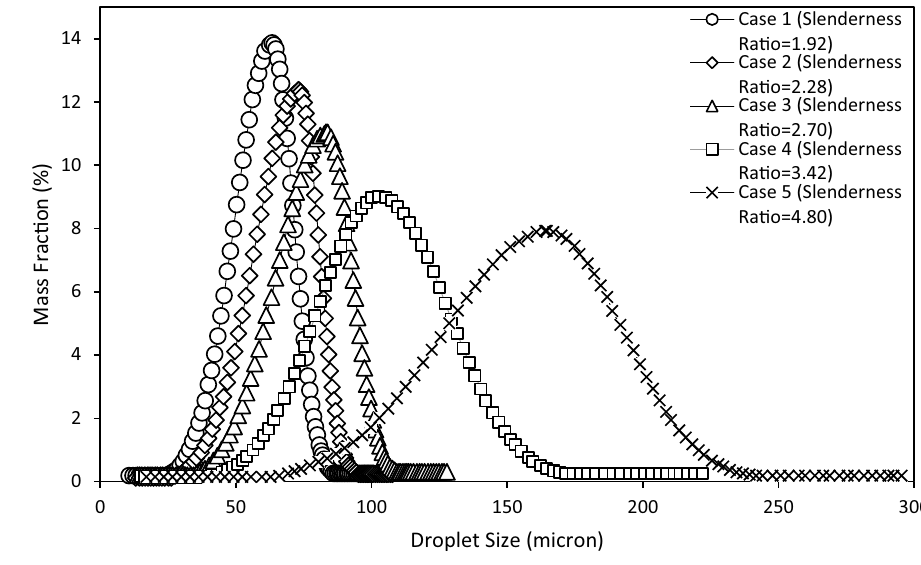
Fig. 12 Simulated diameter distribution of the secondary- phase droplets in the gas outlet of Cases 1–5